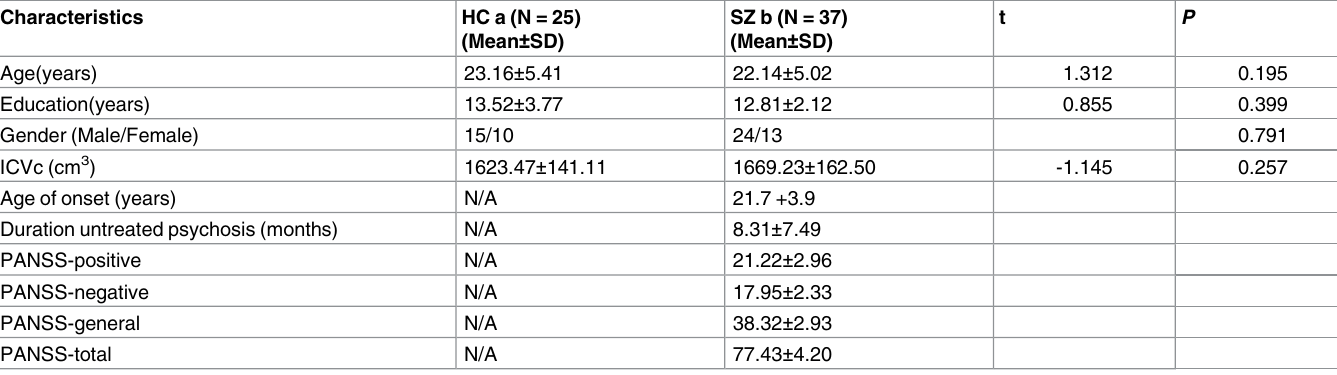
Table 1. Demographic and clinical characteristics of the study